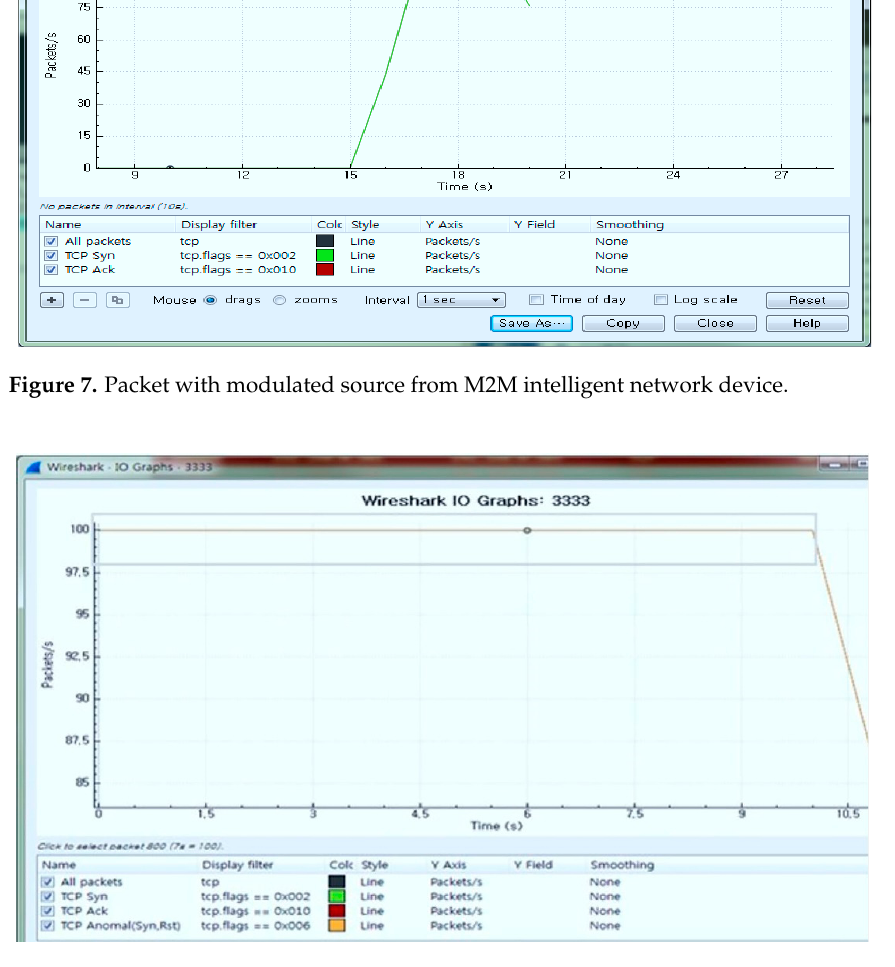
Figure 8. Packet transmission that does not match TCP Flag combination.